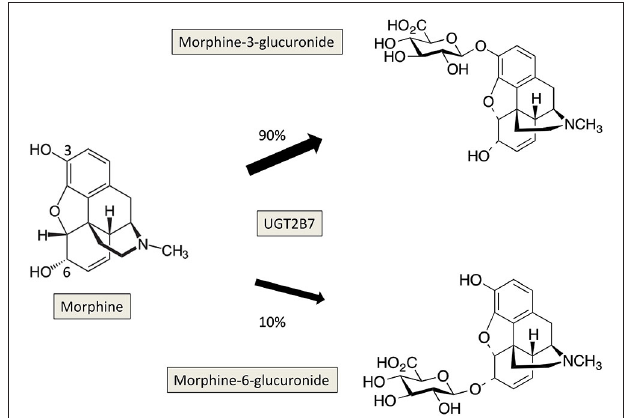
FIGURE 2 | Glucuronidation of morphine by UGT2B7 in human . The reaction occurs on the two hydroxyl groups at positions 3 and 6 of morphine, and leads to the formation of 3-, and 6-glucuronides which present different pharmacological